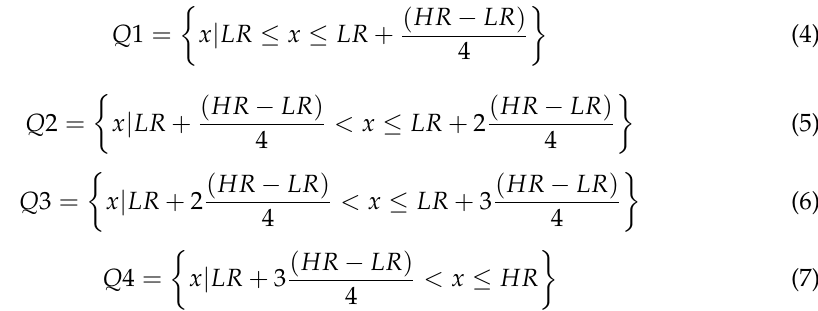
Figure 10. Isnad analysis algorithm flowchart.